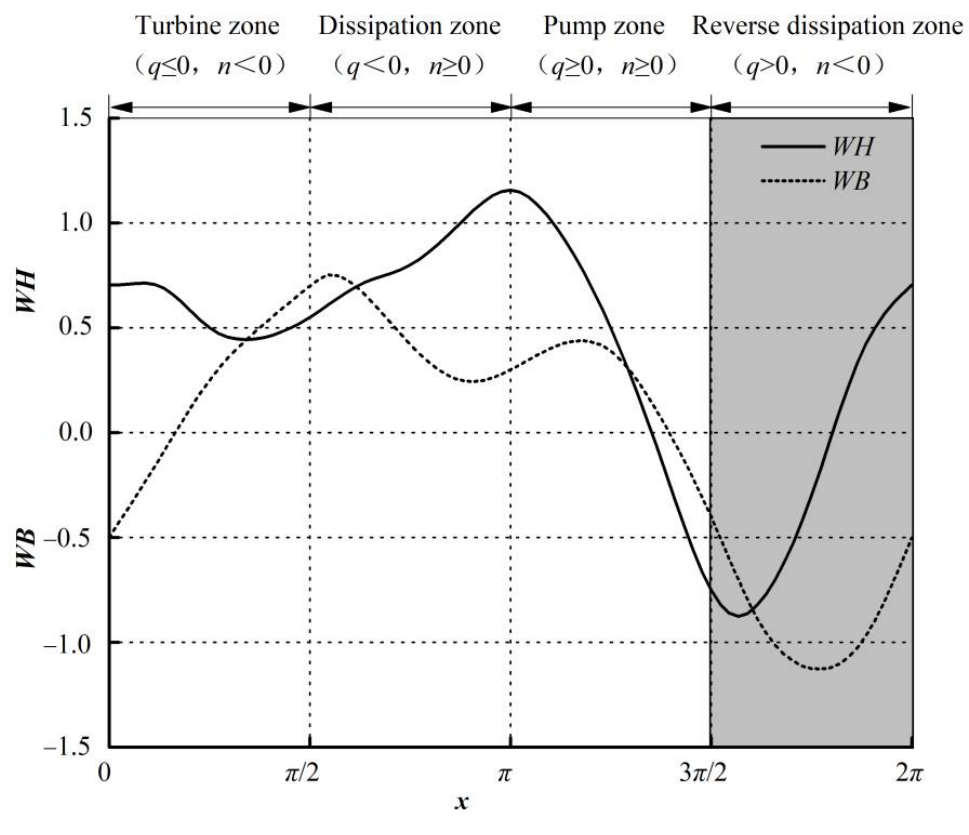
Figure 3. Complete characteristic curves and operation zones of the pump.